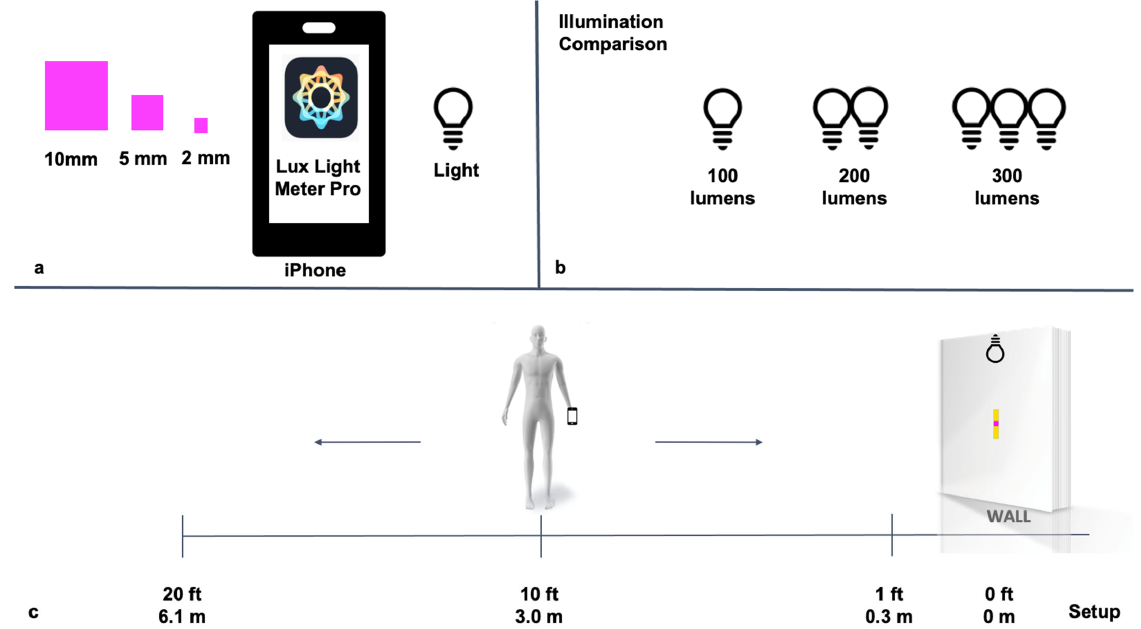
Figure 6. Protocol 4: Configuration for testing luminosity. Neon markers were made as in Protocol 1, Lux Light Meter Pro application downloaded and set on an iPhone ( a ). Various luminosities were set by using the Lux Light Meter Pro to average the light in the room ( b ). Videos were captured at 1–20 ft increments with varying luminosities ( c ).